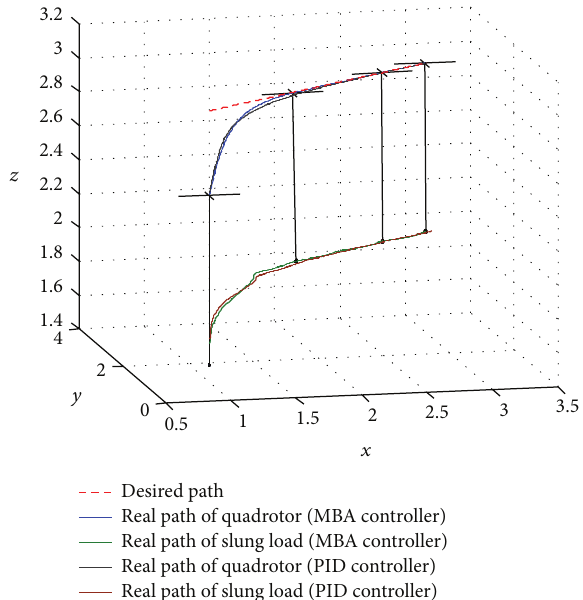
Figure 7: Linear path of quadrotor slung load system.